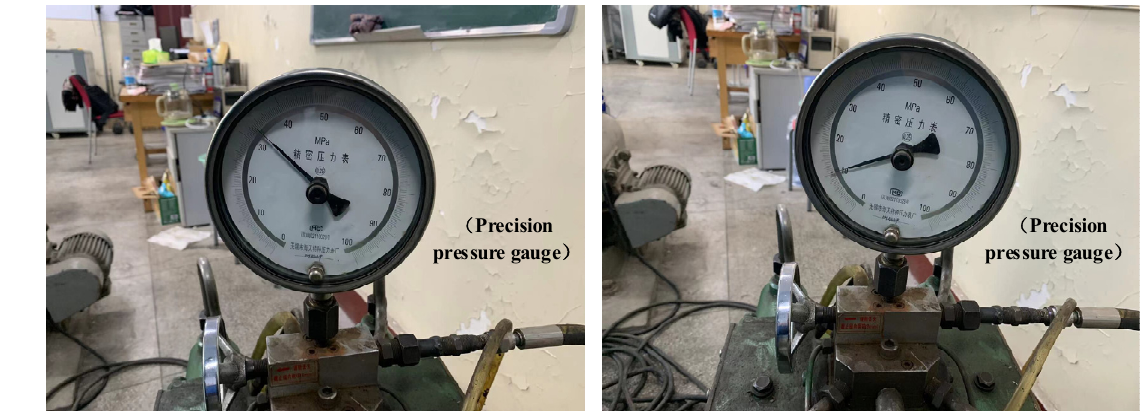
Figure 23. Data recorded by the pressure gauge. Table 5. Records of inner cavity pressure test.